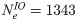
Contrasting datasets obtained in numerical experiment 1.For each dataset (series A to D), the composition of eight populations was observed at six sampling dates, from 6 to 34 days post-inoculation, in independently sampled hosts. Within each plot, each bar represents the composition of the population in one plant at one date, and the last bar shows the mean frequencies over these populations. The color code at the top is used to distinguish the five variants. The harmonic mean of effective population size is indicated in the main title of each plot. The parameter values used for the simulations are: series (A) r = (0.971, 0.92, 1.09, 0.992, 1.027), NeIO=1343, NeS1=822; series (B) r = (1.05, 1.005, 1.077, 0.963, 0.904), NeIO=1815, NeS1=12; series (C) r = (1.045, 1.031, 1.12, 0.879, 0.924), NeIO=45, NeS1=1473; series (D) r = (1.105, 0.943, 0.999, 1.041, 0.912), NeIO=10, NeS1=1025. Note that NeS1 is used for the iterative computation of a sequence of effective population sizes varying each five generations during the systemic infection stage.